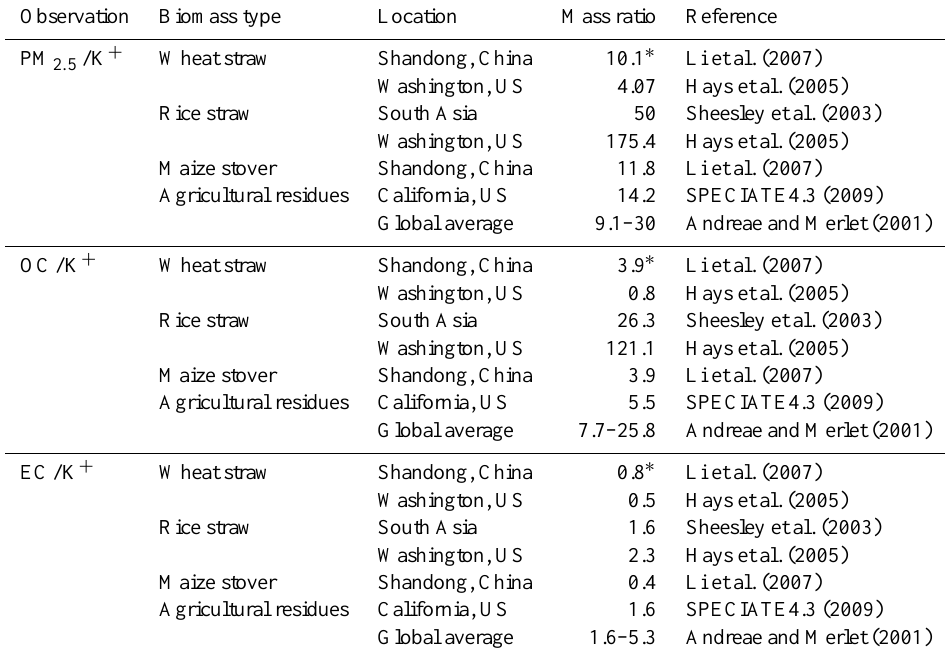
Table 2. Mass ratio of PM 2 . 5 , OC and EC, normalized to water-soluble potassium (K + ) in literature